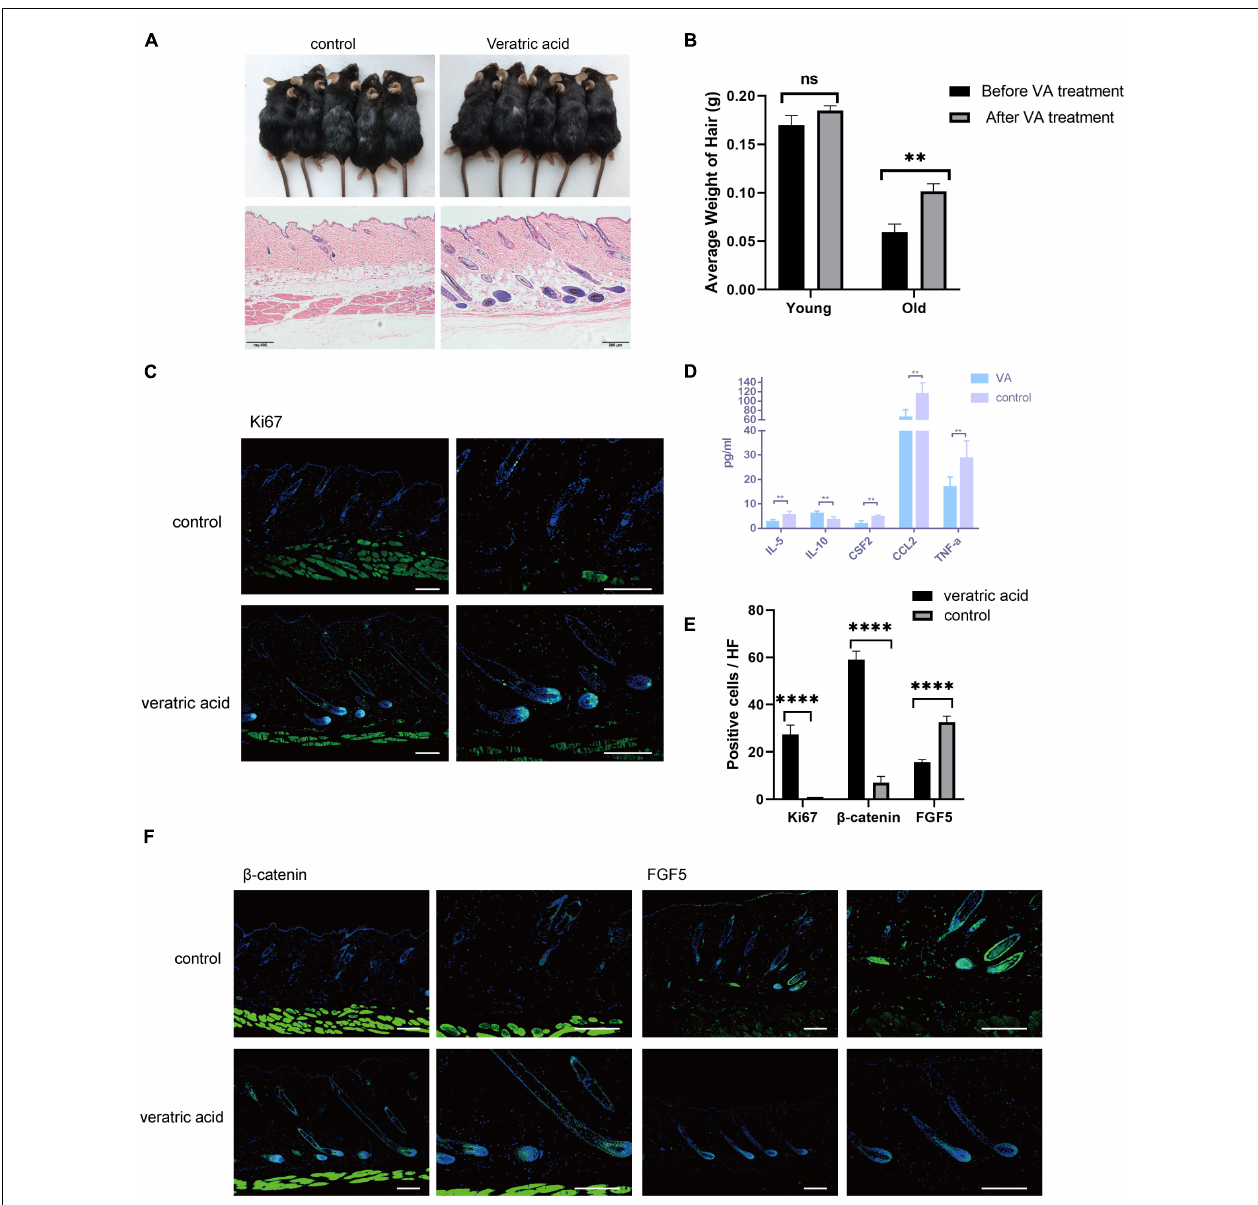
FIGURE 5 | VA injection stimulated HF regrowth by lowering dWAT inflammation. (A) VA injection stimulated HF regenerative behavior in aged mice. (B) The weight of the back skin hair in the old mice after VA treatment was significantly heavier than that before VA treatment, while no difference was found in young mice. n = 10. (C) Increased ki67 signaling was identified in the VA group. Scale bars = 100 µ m. (D) Decreased levels of TNF-a, CCL2, IL-5, CSF2, and increased IL-10 were proved in dWAT after VA treatment. (E) Quantification of positive cells in each hair follicle about ki67, β -catenin, and FGF5. (F) Increased β -catenin signaling and reduced FGF5 level were identified in the VA group. Scale bars = 100 µ m. n = 6. ns, Not Significant. ∗∗ P < 0.01, and *** P <